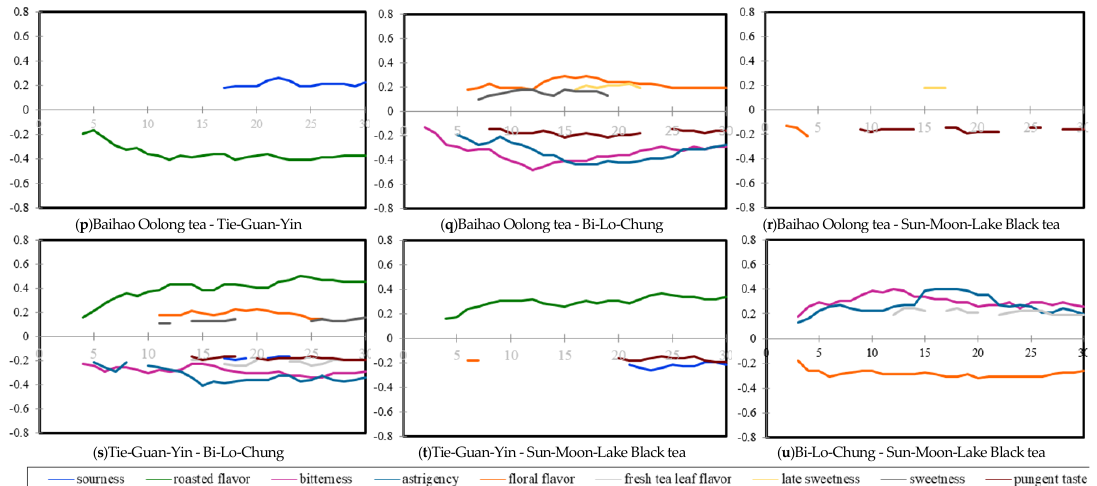
Figure 5. The significant discrimination in citation proportions of temporal check-all-that-apply curve for the nine selected attributes between Taiwanese specialty tea infusions are displayed for each product pair. (a) Wenshen Paochong tea–Tie-Guan-Yin; (b) Wenshen Paochong tea–Bi-Lo-Chung; (c) Wenshen Paochong tea–Sun-Moon-Lake Black tea; (d) High-